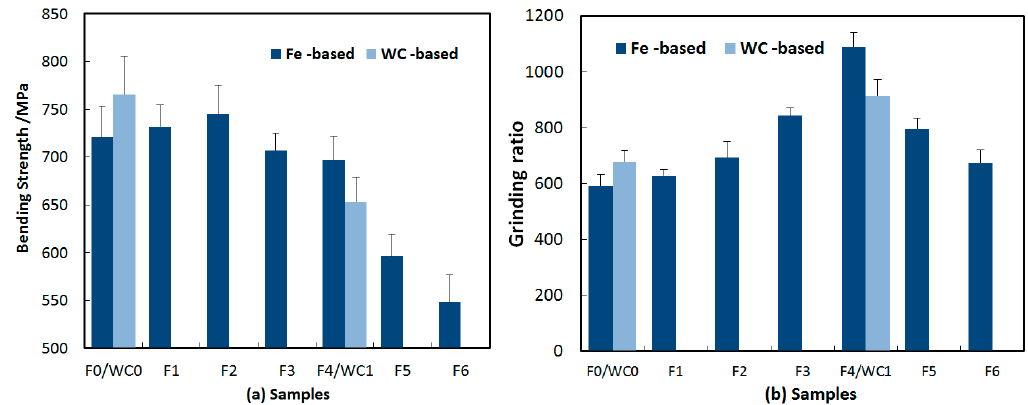
Figure 3. Test results of ( a ) bending strength and ( b ) grinding ratio of samples.